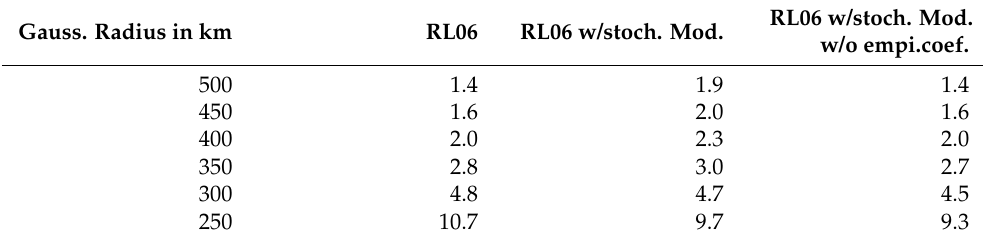
Table 2. Weighted ocean RMS of surface mass densities in cm equivalent water height of the residuals of the three solutions for January 2007, shown in Figure 7 (right) for different Gaussian filter radii (C 20 coefficients neglected). Gauss. Radius in km RL06 RL06 w/stoch. Mod.